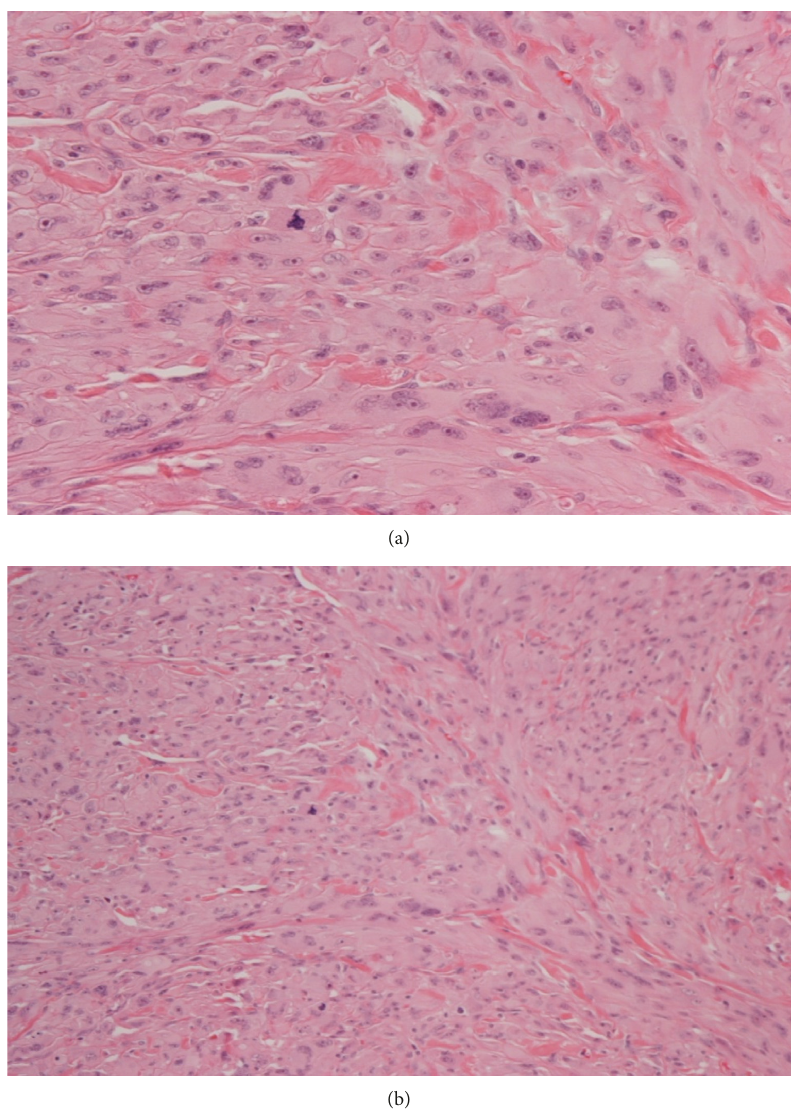
Figure 4: Photomicrograph of excised nodular lesion (H&E stain) showing a dermal spindle cell lesion exhibiting marked pleomorphism and brisk mitoses. Immunohistochemically, focal staining with CD68 was seen. Morphologically and immunohistochemically, the features are consistent with AFX. (a) × 40 magnification. (b) × 20